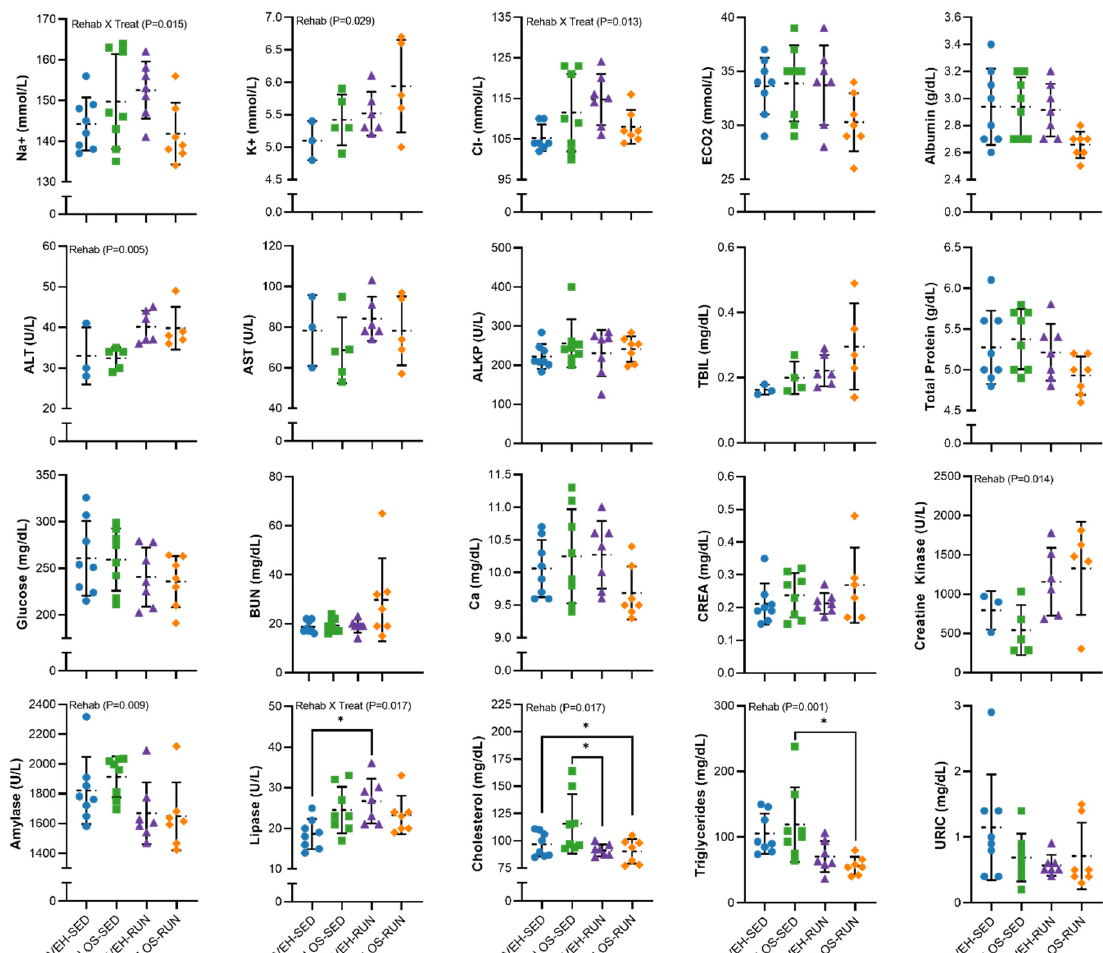
Figure 7. Serum metabolite evaluation at 56 days post-VML injury. Serum metabolites were analyzed for hepatic, renal, electrolyte, and additional metabolic panel markers. Data are presented as mean ± SD; n = 3–8 rats per group. Differences were considered significant when p < 0.05 by a two-way ANOVA followed by the Holm–Sidak post hoc test. The * indicates a significant difference of p < 0.05.